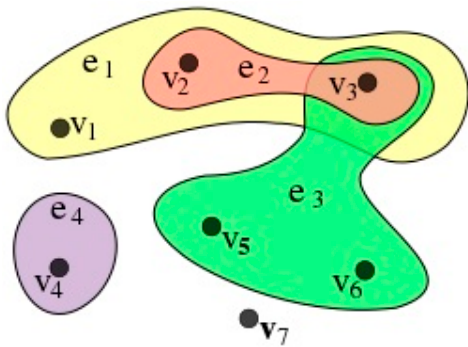
edges Figure2. Anexampleofthehypergraphwhichhasvertices v = { v 1 , v 2 , v 3 , v 4 , v 5 , v 6 , v 7 } , andhyper-edges e = { e 1 , e 2 , e 3 , e 4 } = {{ v 1 , v 2 , v 3 } , { v 2 , v 3 } , { v 3 , v 5 , v 6 }} .